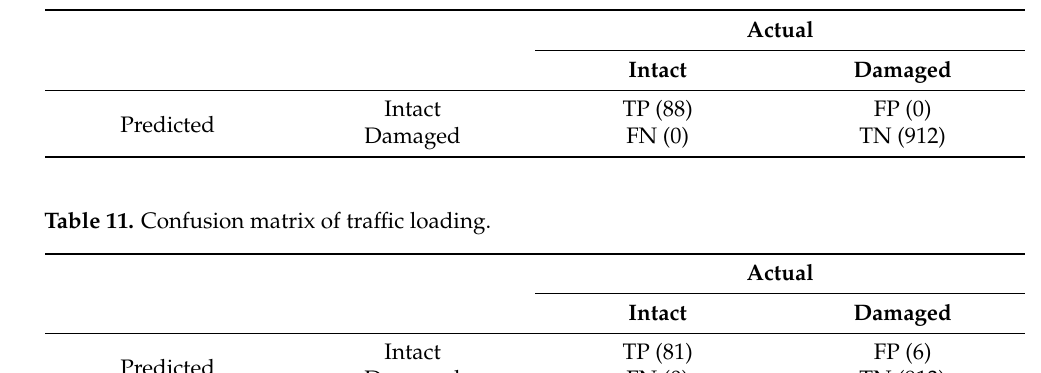
Table 10. Confusion matrix of random excitation.